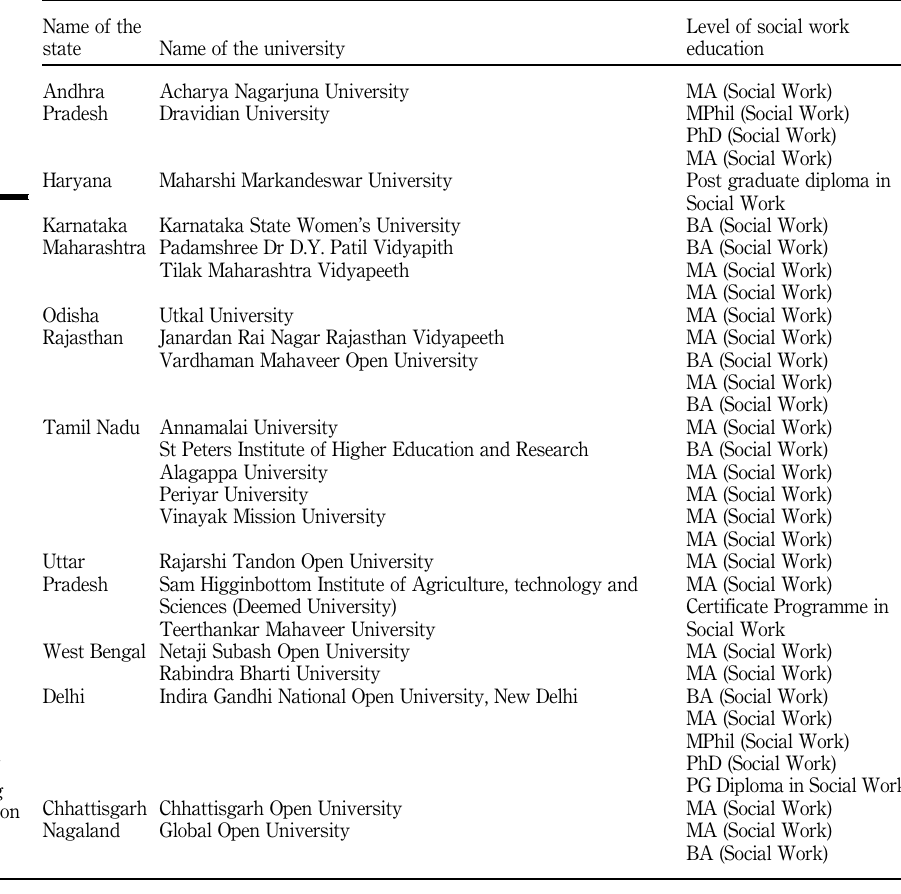
institutions offering social work education through open and distance